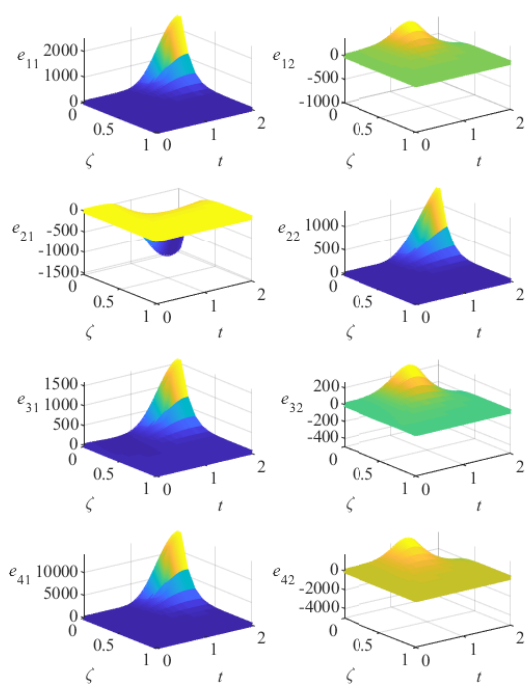
Figure 1. e ( ζ , t ) of HPDECSTN (1) without